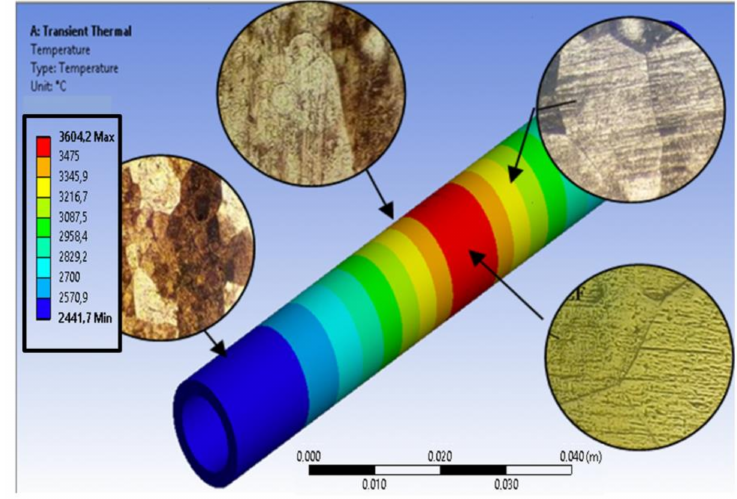
Figure 7. Temperature distribution and